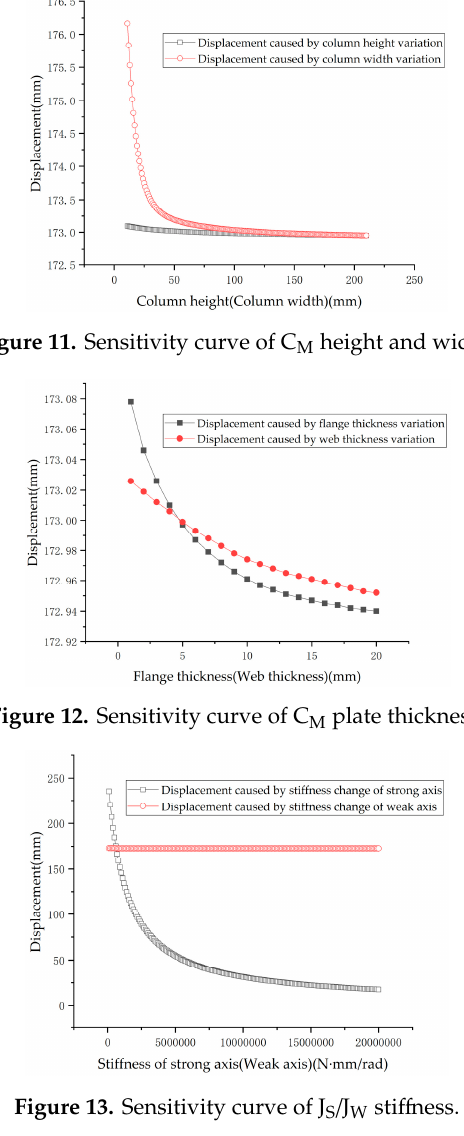
Figure 10. Sensitivity curve of C S plate thickness.